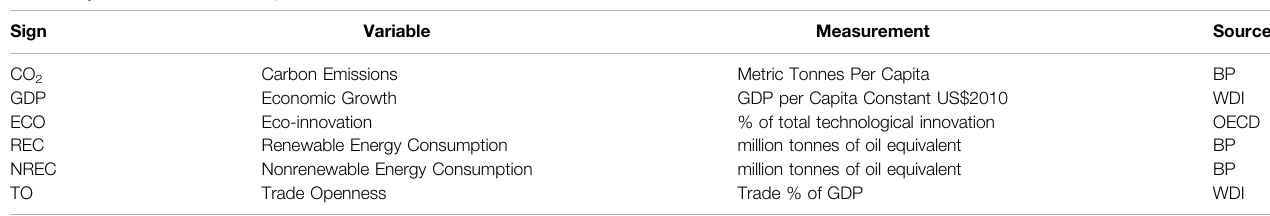
TABLE 2 | Data source and